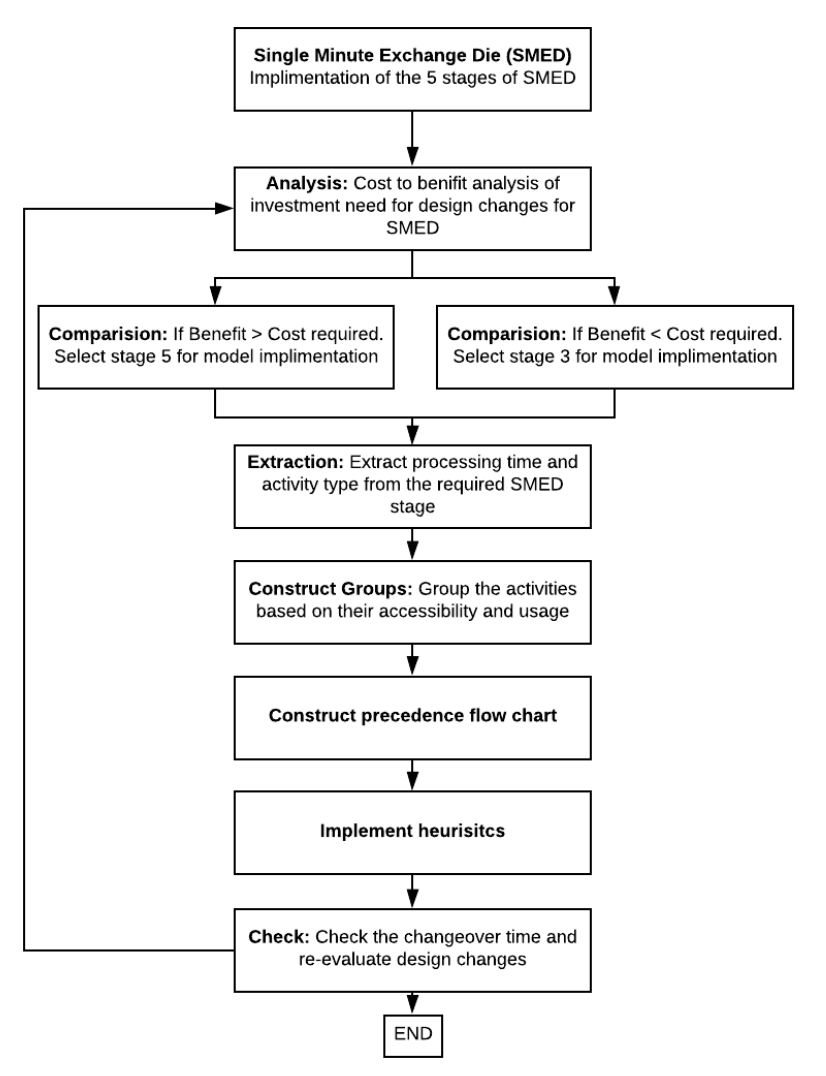
Figure 1. Research flow